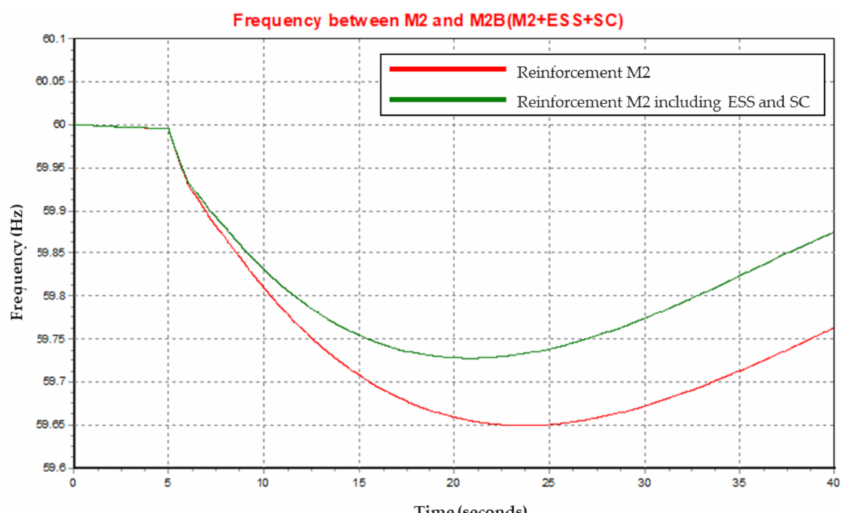
Figure 11. Frequency between M2 and M2B.